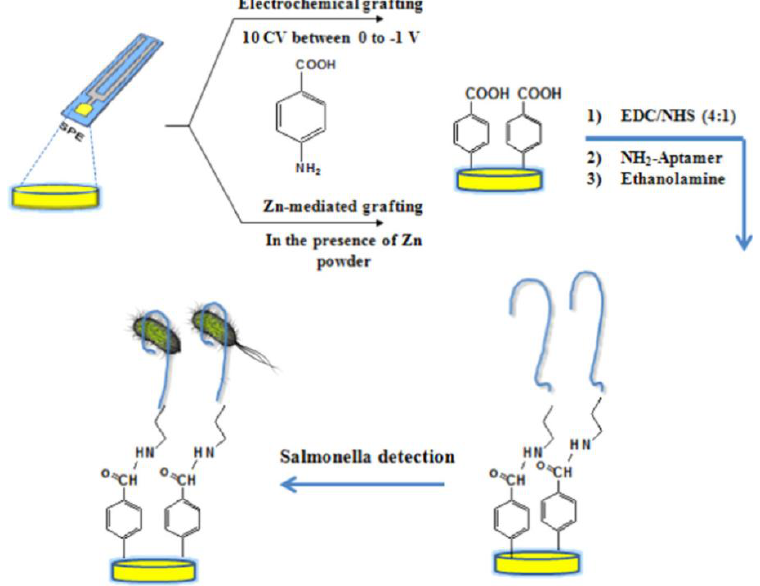
Figure 9. Overview of the preparation of the S. typhimurium aptasensor. Reprinted from [95] with permission.